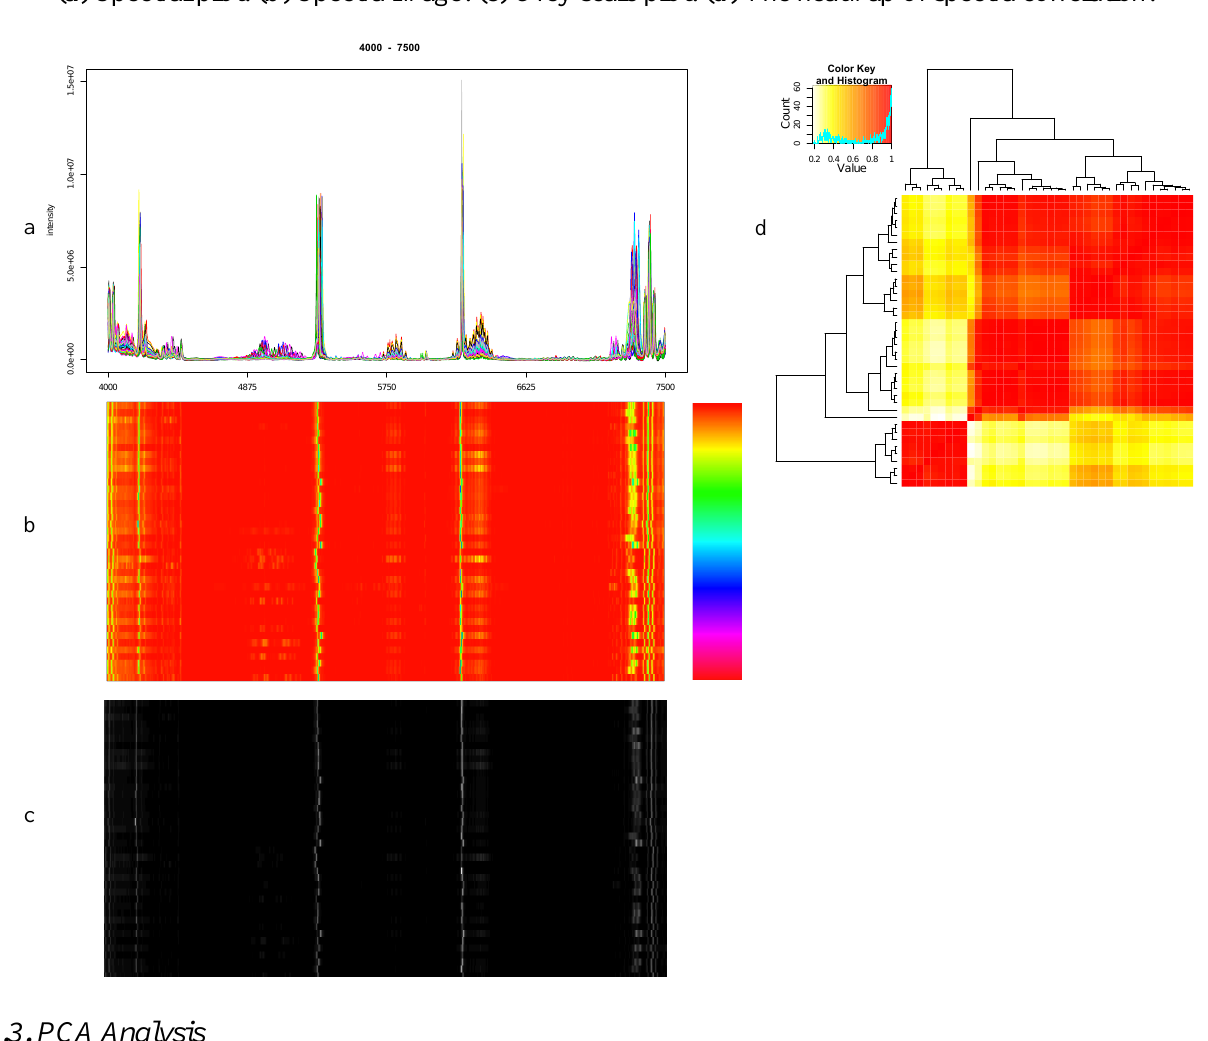
Figure 4. Examples of evaluation by using visualizations for a region in the Wine data